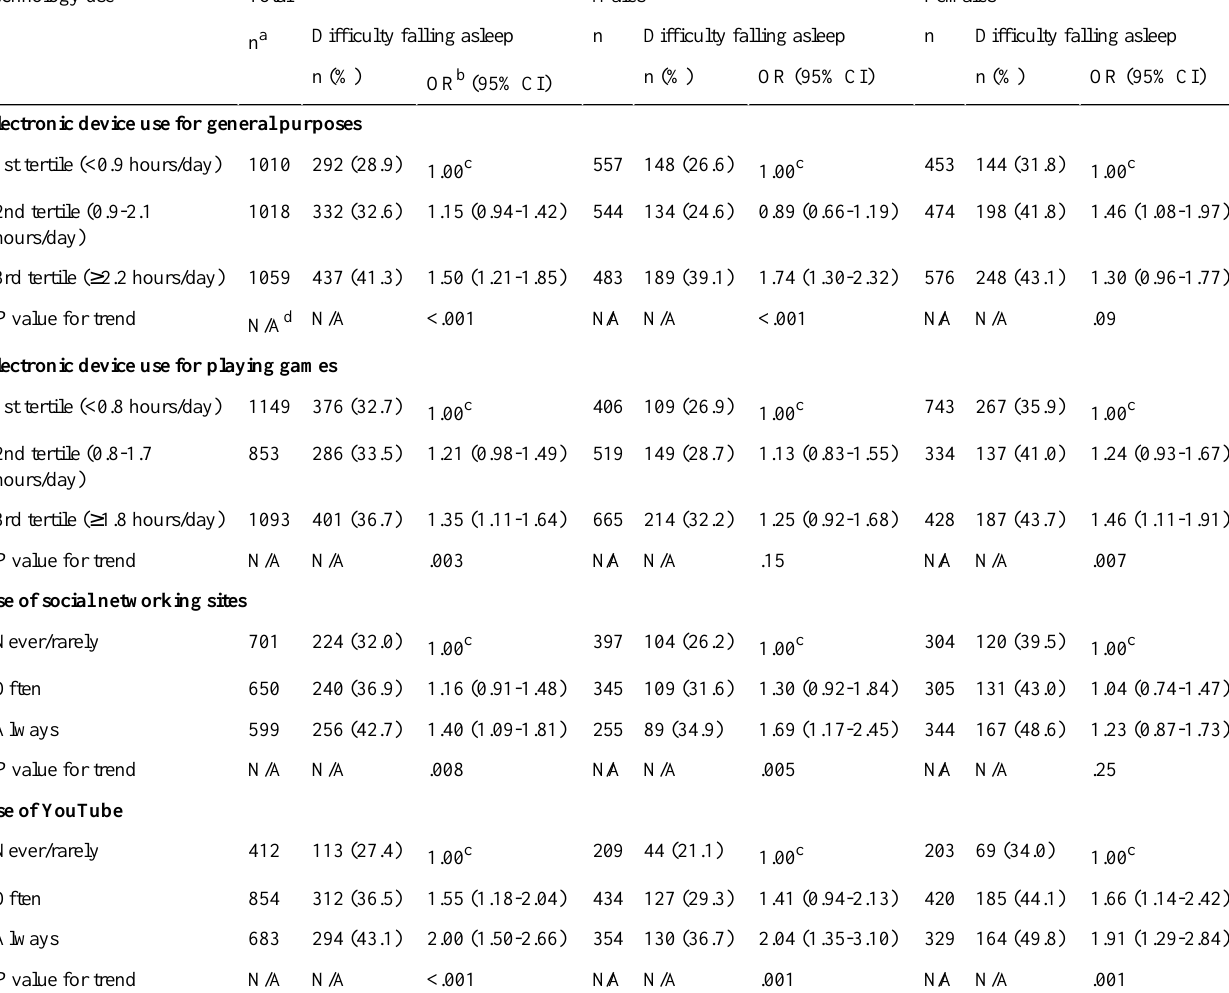
Table 1. Distribution of 3172 adolescents with sleep difficulties overall and by technology and social media use, with corresponding odds ratios and 95% CIs for the full sample and sex-specific samples (Lombardy, 2014). FemalesMalesTotalTechnology